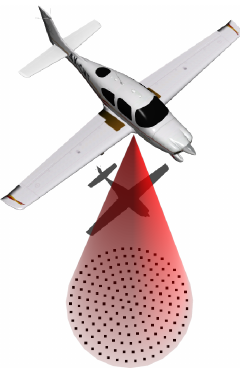
Figure 2: HELIOS simulates beam divergence using multiple subsampling rays. Each black dot represents one subsampling ray. For visualization purposes, the rays themselves are not shown and the illustration is not to scale. Aircraft 3D model: CC-BY-SA Emmanuel